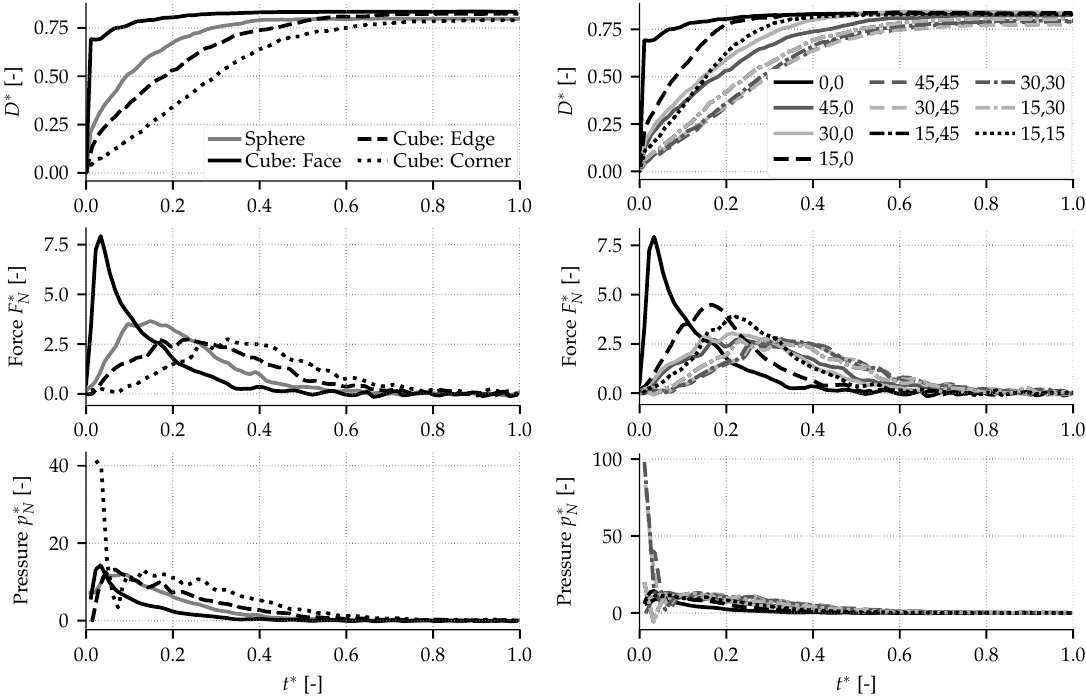
Figure 11. Comparison of change in nondimensional spreading diameter ( top ), total normal force ( middle ) and contact pressure ( bottom ) with nondimensional time for the main cube orientations and the sphere ( left ) and for all cube impact orientations ( right